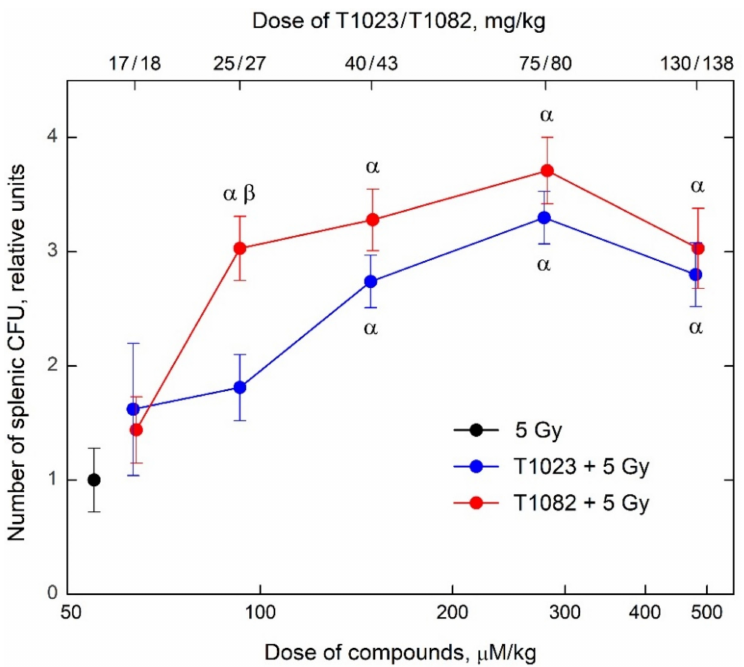
Figure 2. The effect of compounds T1023 and T1082 (single, i.p., 30 min before irradiation) in equimolar doses corresponding to 1/18, 1/12, 1/8, 1/4, and 1/2 LD 10 on the number of endogenous splenic CFU in F 1 (CBA × C 57 BL 6j ) mice on day 8 after 5 Gy γ -ray TBI. Data represent the combined results of two independent experiments—data for each experiment are normalized to the mean number of CFU in the irradiated control (see Section 4.5) and graphical deviations correspond to SD ( n = 32–34 per point). α , significantly different vs. irradiated control mice (for T1023: p = 0.00734, p = 0.00012, and p = 0.00487; for T1082: p = 0.00263, p = 0.00028, p = 0.00004, and p = 0.00180, respectively). β , significantly different between mice treated with T1023 and T1082 at equimolar doses ( p =